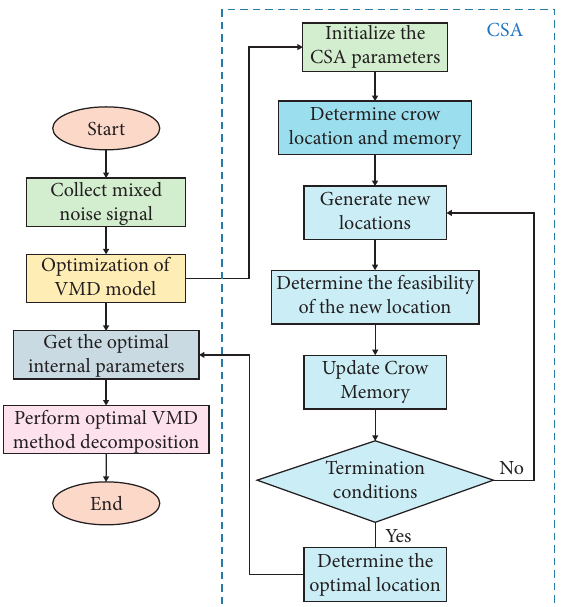
Figure 4: The flowchart of CSA-VMD